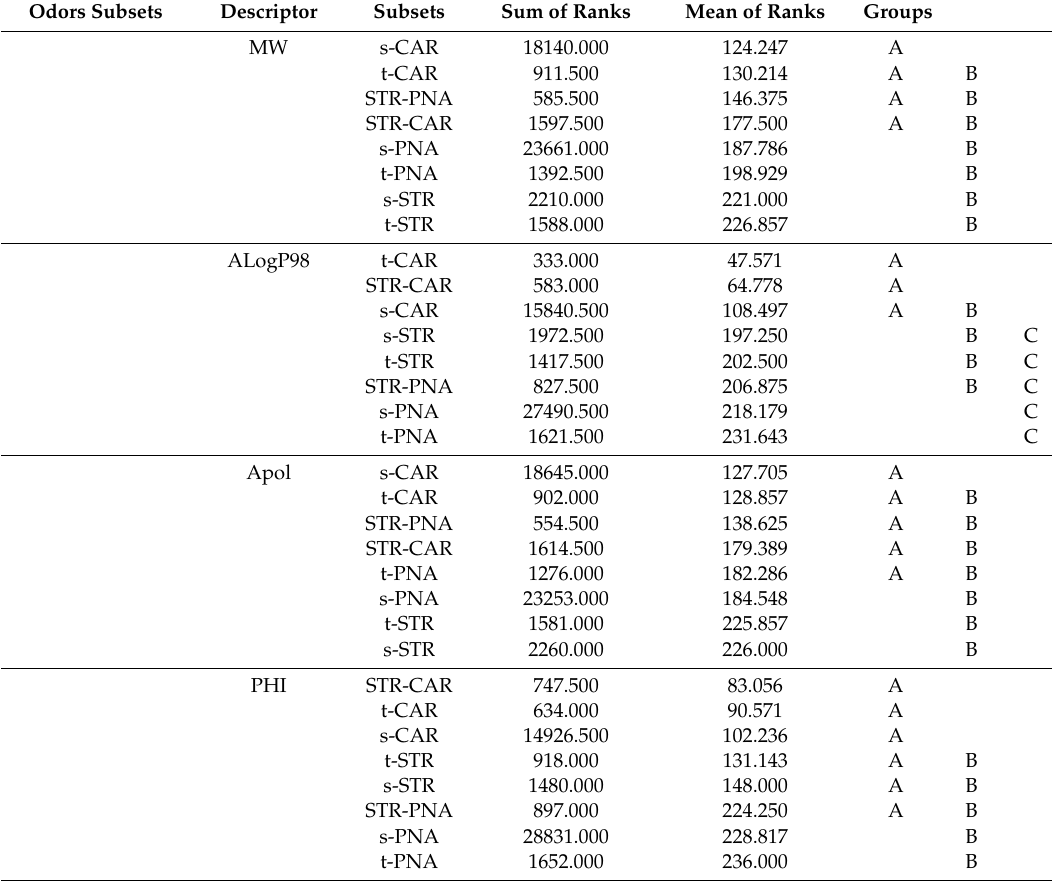
Table 4. Multiple pairwise comparisons between the odor subsets using Dunn’s